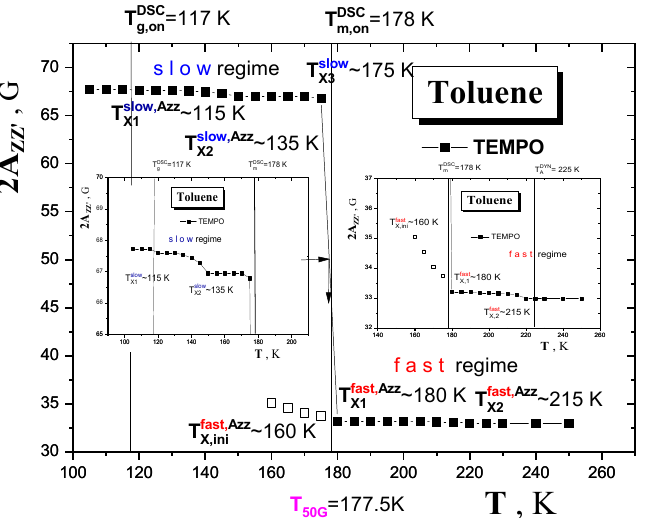
Figure 7. Spectral parameter of mobility 2 A zz‘ as a function of temperature for the spin system TOL/TEMPO. Insets show the details of the slow and fast motion regime regions. Error bars are of the point size.